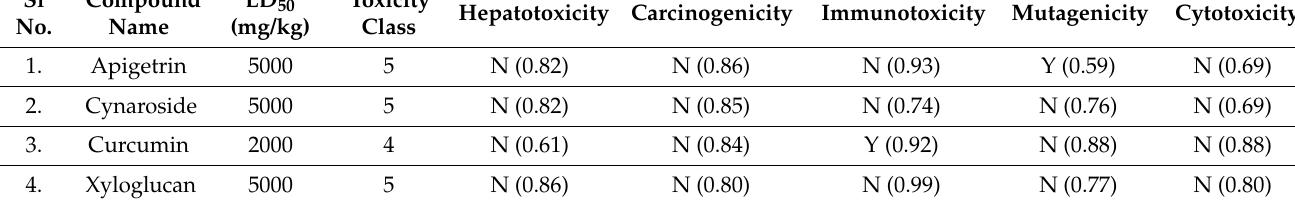
Table 2. Toxicity prediction of the